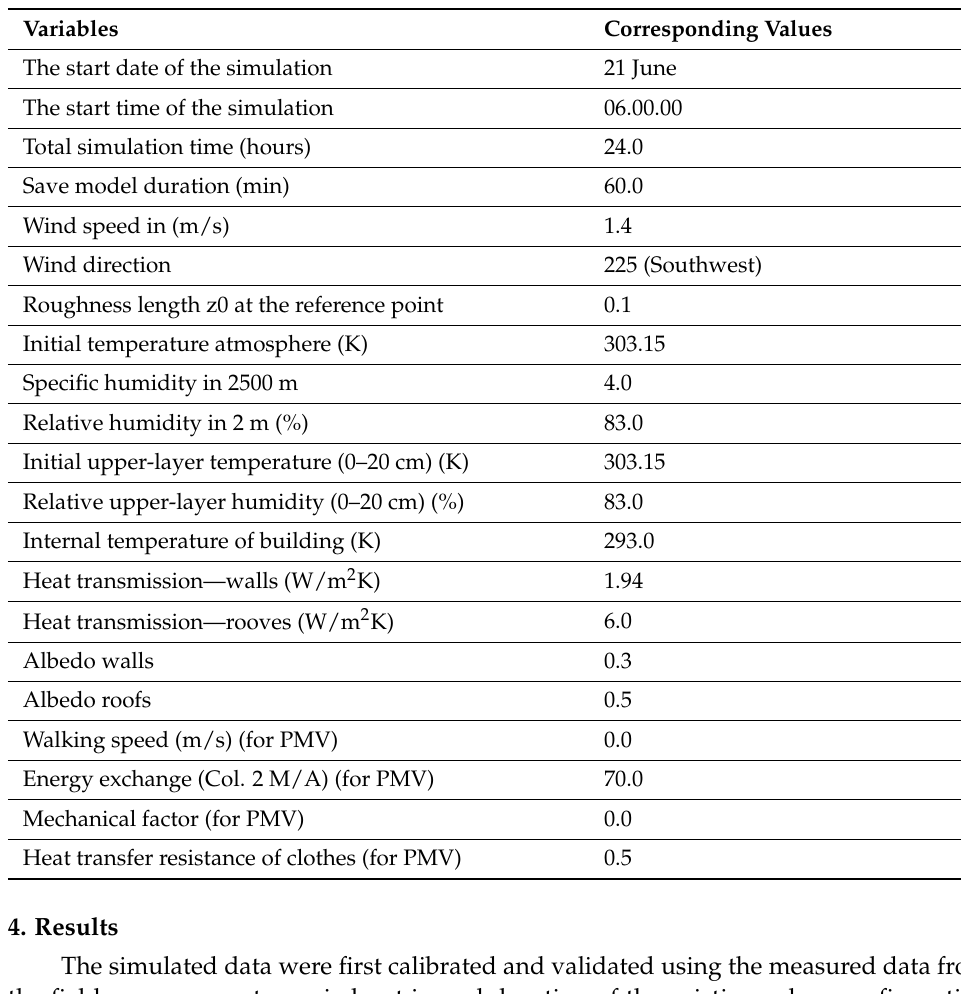
Table 4. Summary of the input parameters considered for the simulations.